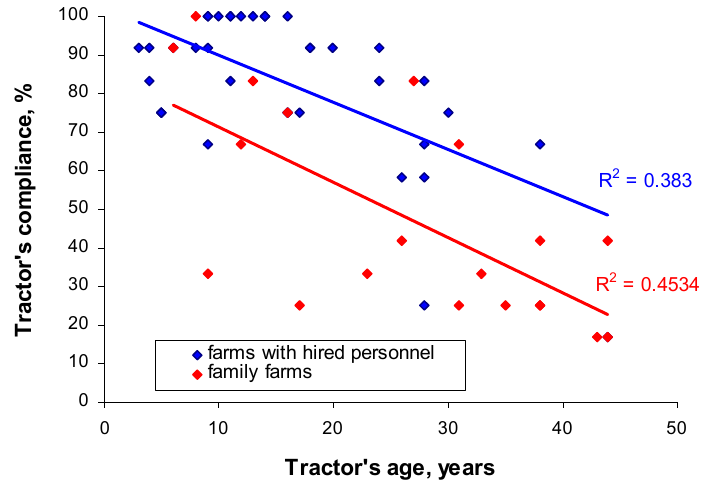
Figure 5. Tractor’s compliance (% of compliant items) vs. tractor’s age (years) in farms with or without hired personnel.